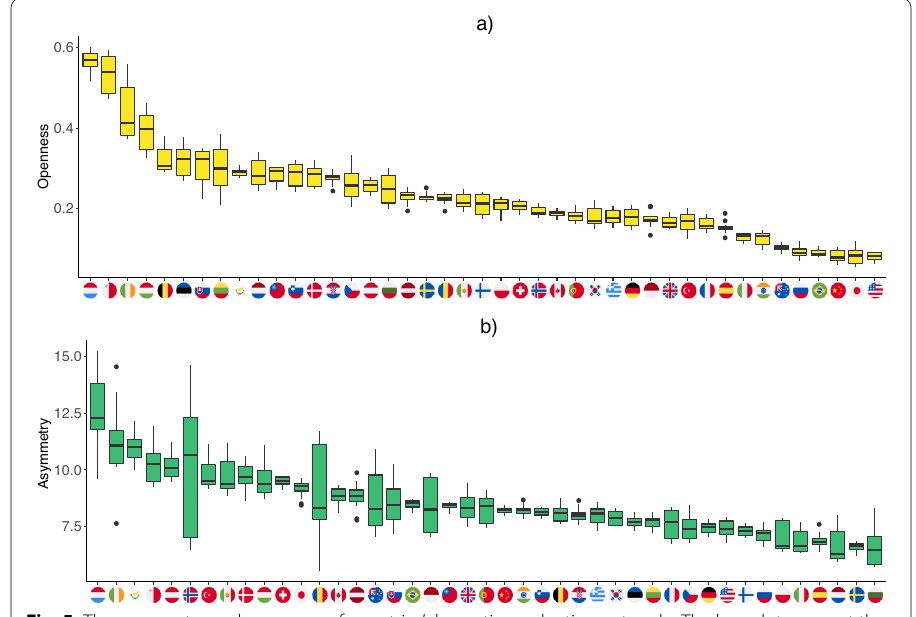
Fig. 5 The asymmetry and openness of countries’ domestic production networks. The box plots present the values between 2000 and 2014 by countries, ordering by the mean values. a Openness, b